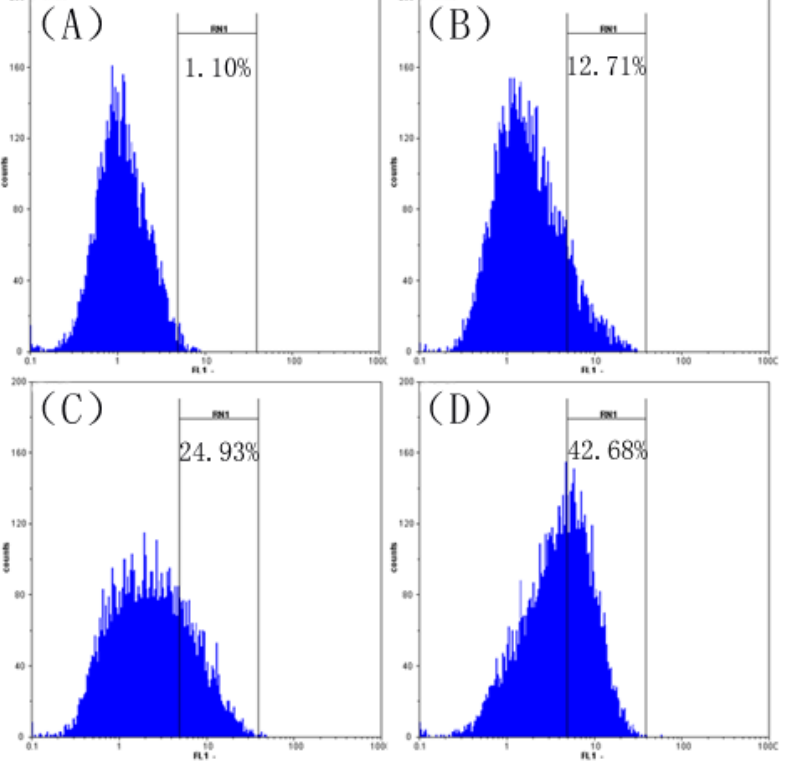
Figure 6. Effect of SFE-CO extract on ROS of SMMC-7721 cells assayed by flow 2 cytometry analysis of DCFHDA stained cells. ( A ) Untreated control cells; ( B )-( D ) treatment with 50, 100, and 200 μ g/mL SFE-CO 2